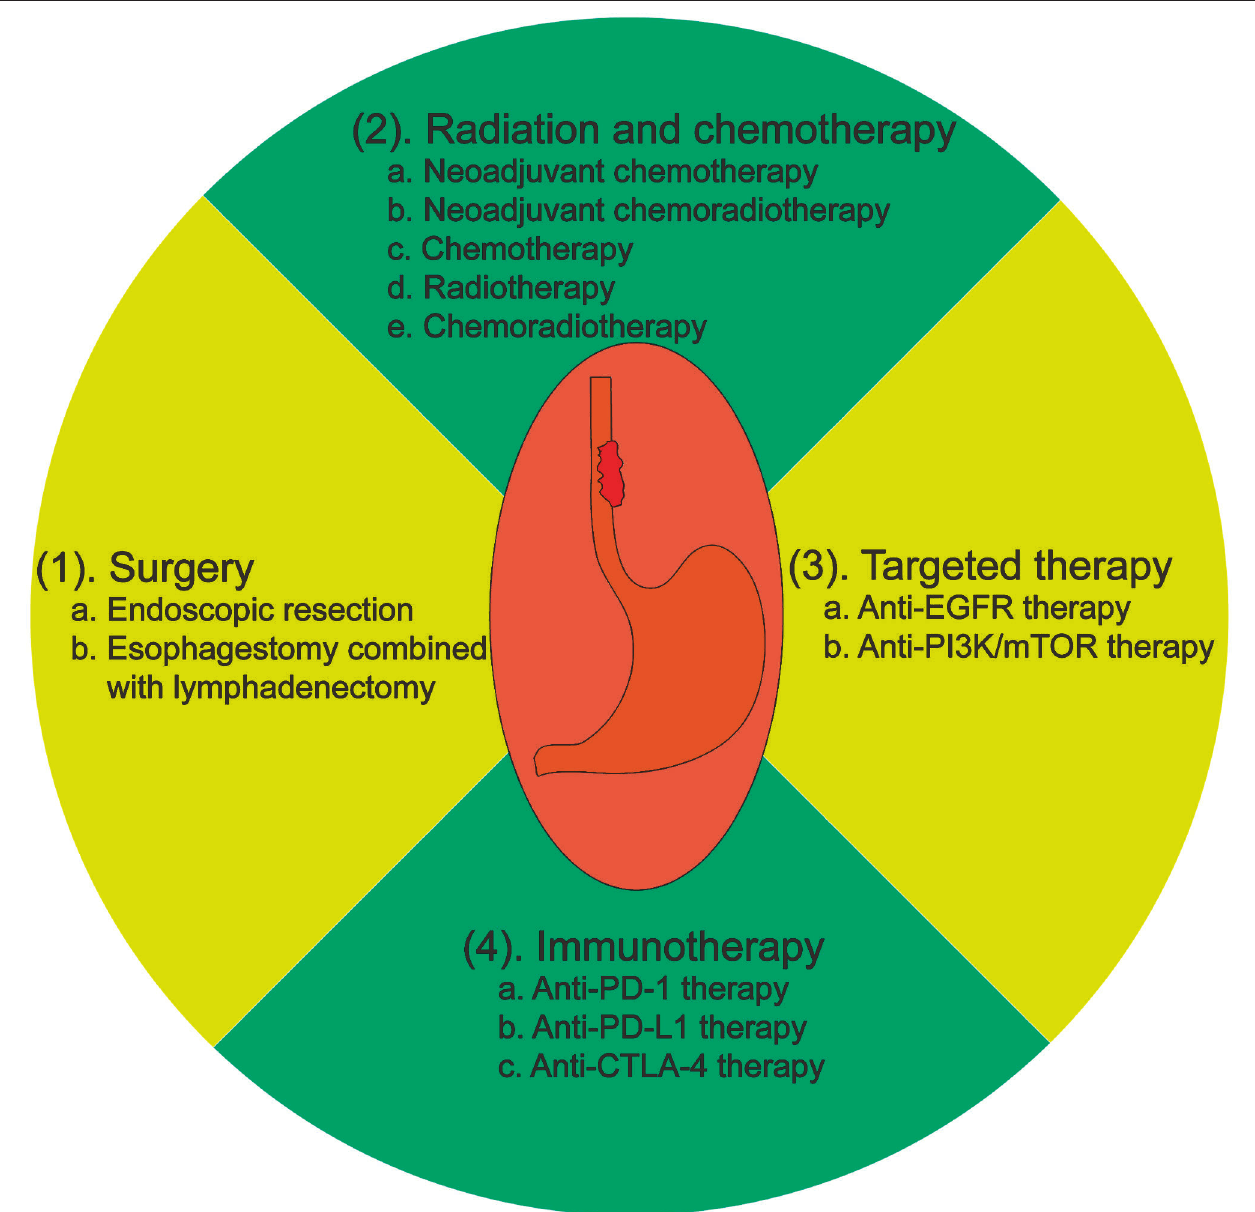
FIGURE 2 | Current treatment options for esophageal cancer.